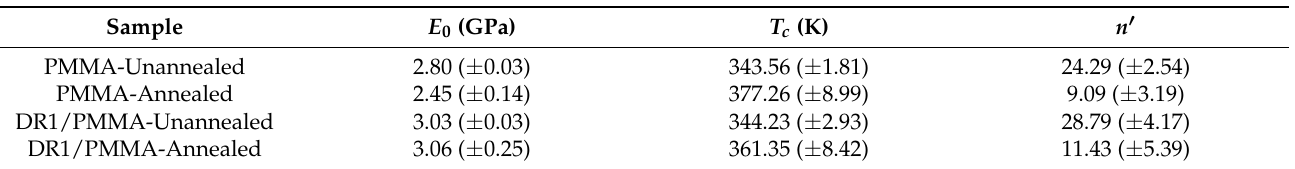
Figure 4. Young’s modulus as a function of temperature for unannealed and annealed PMMA and DR1/PMMA fibers. Table 2. Parameters of Young’s modulus as a function of temperature fitting function for unannealed and annealed PMMA and DR1/PMMA fibers.